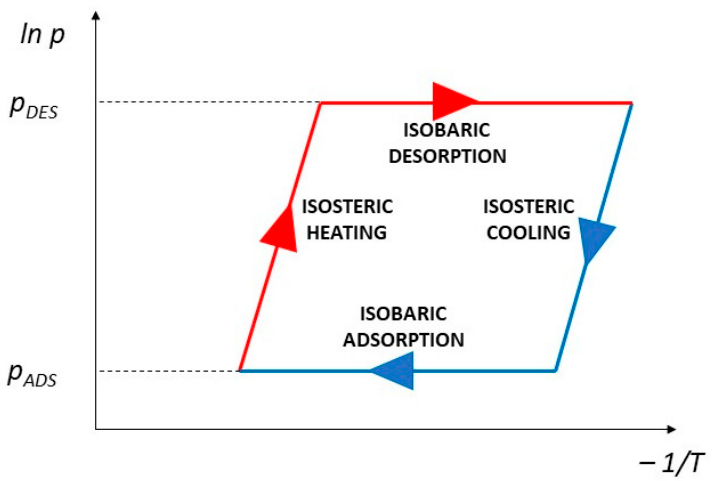
Figure 1. Diagram of pressure and temperature changes in the sorption cycle of the adsorption chiller’s bed.